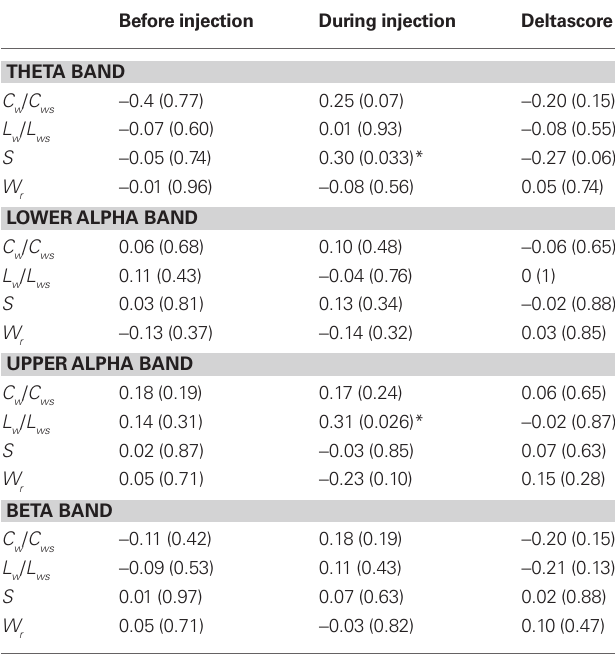
Table 2 | Test statistics of variables (lesion type, lesion lateralization, gender) possibly confounding changes in network